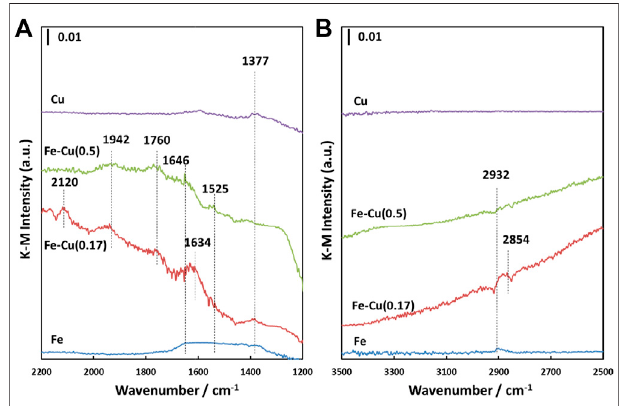
FIGURE 6 | In situ DRIFT spectra of Fe-Cu(X)/Al 2 O 3 catalysts after CO 2 hydrogenation at 523 K and atmospheric pressure for 30 min (A)